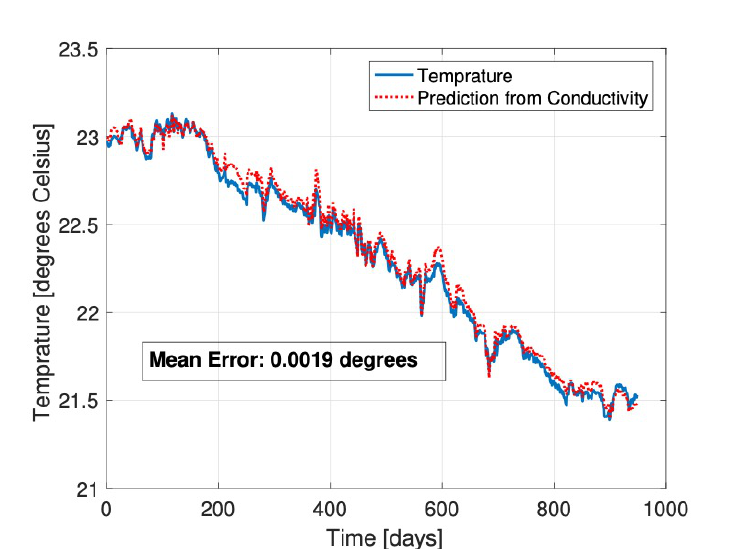
Figure 7. THEMO water temperature data (blue) and its prediction from conductivity data (red), as obtained by the support vector regression (Radial Basis Function (RBF) kernel) method.